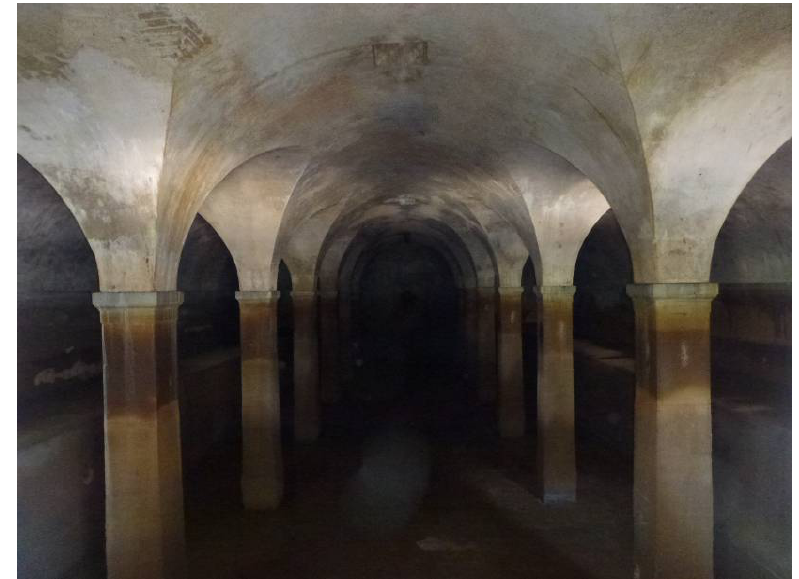
Figure 11. Cistern of Hadrian in Athens, as it was rebuilt after the original design in the 1880s (photo copyright by G.P. Antoniou).